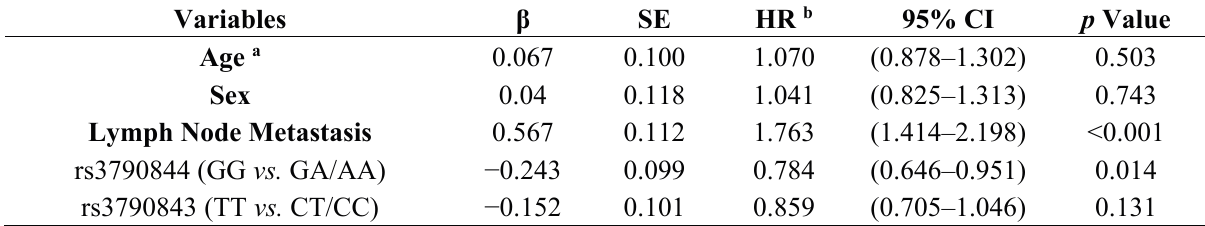
Table 6. Stepwise Cox regression analysis on the survival of